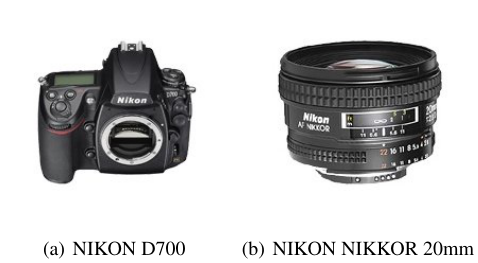
Figure 1: Used camera and lens